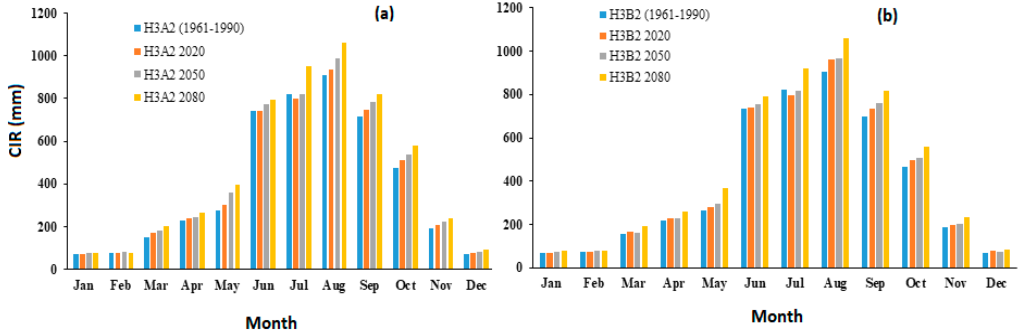
Figure 9. Monthly summation of CIR of five agricultural crops under ( a ) H3A2 and ( b ) H3B2 scenarios in Rechna Doab.